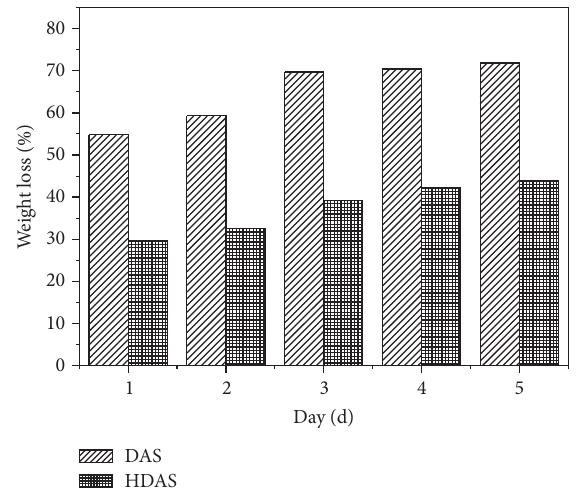
Figure 6: Hydrophobicity testing of DAS and